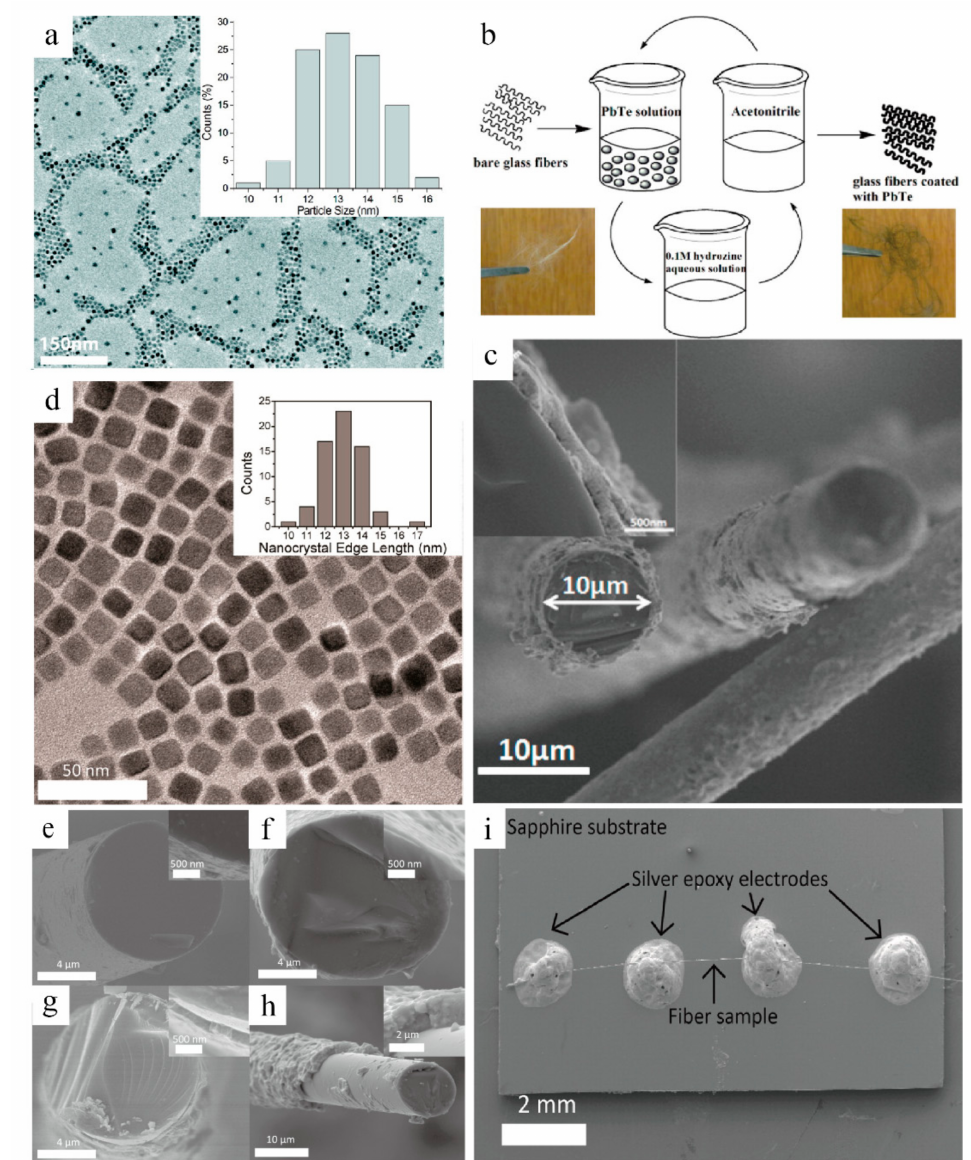
Figure 2. ( a ) TEM image of PbTe nanocrystals; upper inset is the size distribution of PbTe nanocrystals. ( b ) Scheme of the coating procedure to fabricate the bare glass fibers and PbTe nanocrystal-coated glass fibers. ( c ) SEM image of glass fibers coated by PbTe nanocrystal with a thickness ~300 nm. Reproduced with permission [34]. Copyright 2012, American Chemical Society. ( d ) Low-resolution TEM image of PbTe nanocrystals with the inset of size distribution. ( e – h ) Cross-section SEM images of cut ends of glass fibers based on PbTe samples. ( i ) SEM image of the PbTe fiber sample used for 3 ω measurements. Reproduced with permission [38]. Copyright 2013, American Chemical